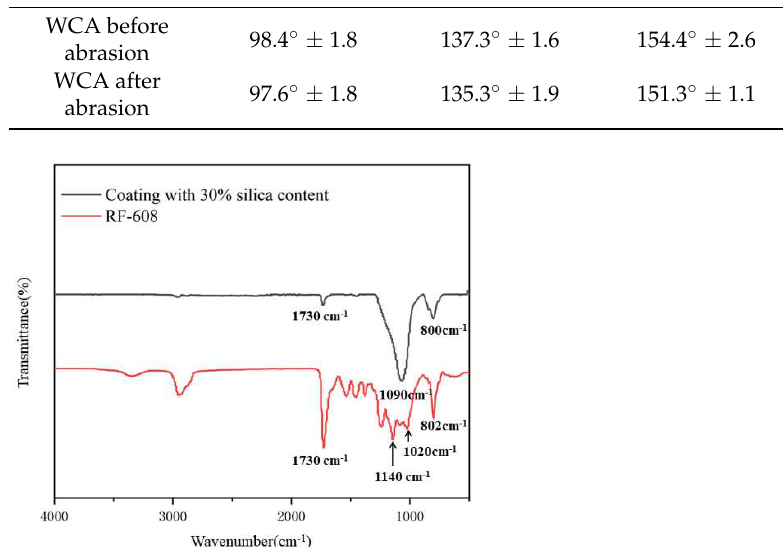
Figure 7 . FTIR spectra of coatings with 30% silica content and pure RF-608 . Figure 7. FTIR spectra of coatings with 30% silica content and pure RF-608.